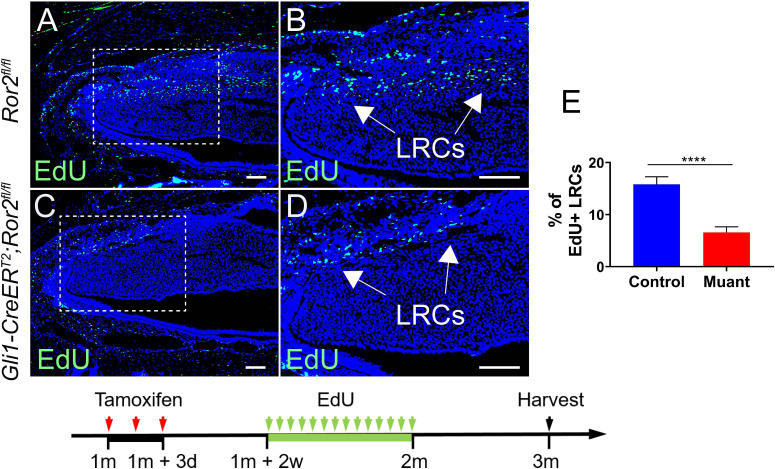
Loss of Ror2 results in diminished EdU+ label retaining cells (LRCs).(A–D) EdU staining of Ror2fl/fl and Gli1-CreERT2;Ror2fl/fl mouse incisors. (E) Quantification was performed by calculating the percentage of EdU+ cells per section of Ror2fl/fl and Gli1-CreERT2;Ror2fl/fl incisor mesenchyme under higher magnification (B and D). Schematic underneath figures indicates induction protocol. All quantitative data are presented as mean ± SD. ****, p<0.0001. Scale bars, 100 μm.Figure 6—figure supplement 1—source data 1.Source data for Figure 6—figure supplement 1E.